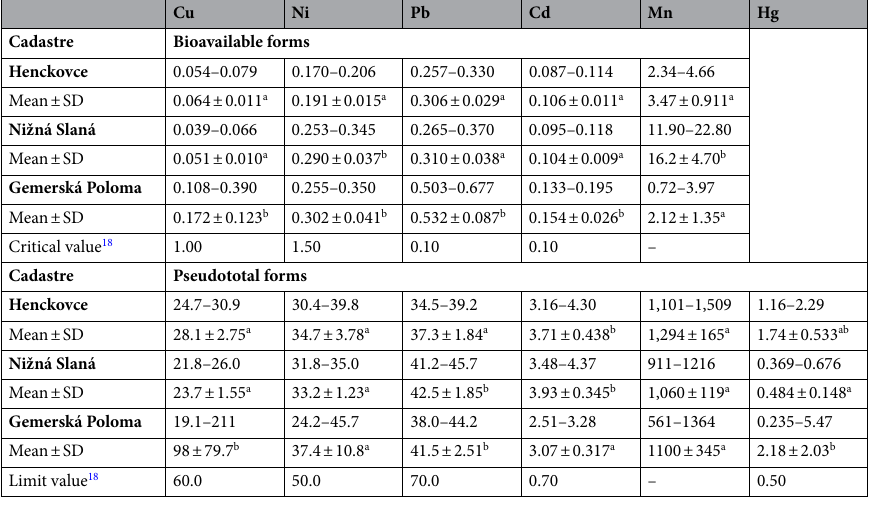
Table 1. The contents of risk elements (Cu, Ni, Pb, Cd, Hg, Mn) in soil (mg/kg). a,b Statistically significant differences between cadastres, P value <